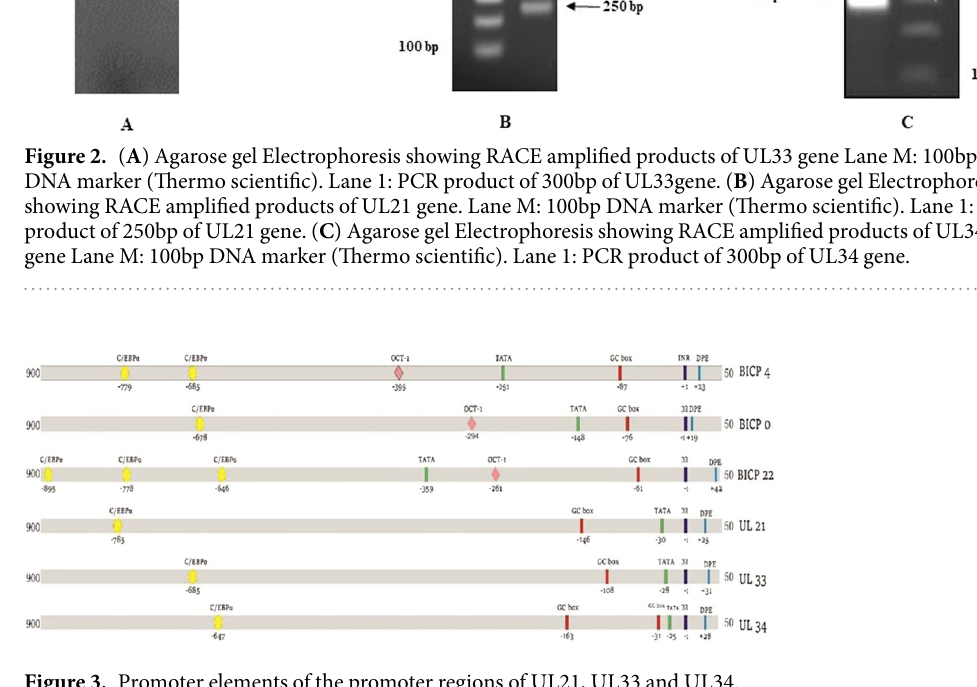
Figure 3. Promoter elements of the promoter regions of UL21, UL33 and UL34.